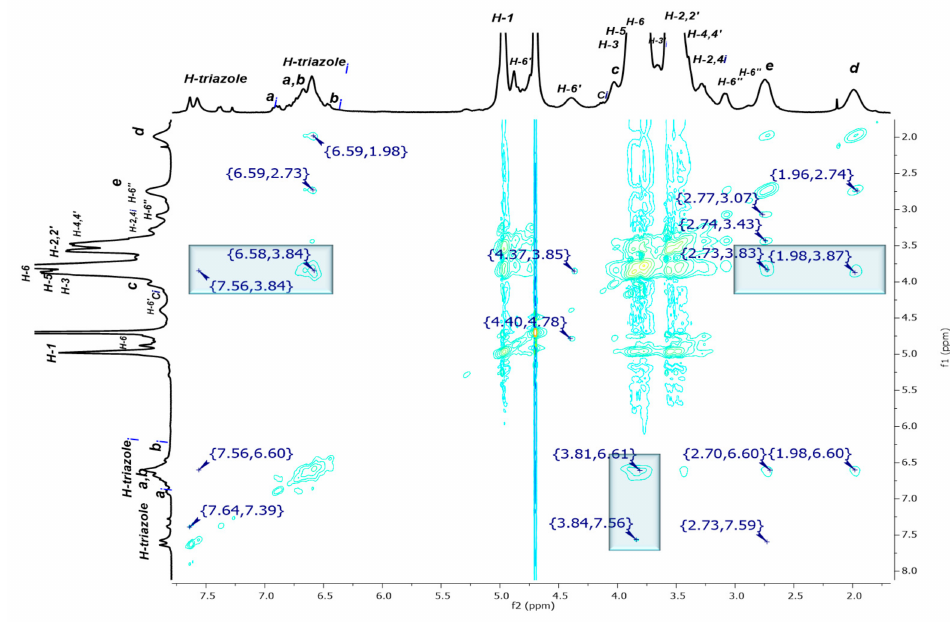
Figure 6. 2D NMR NOESY spectrum of P 3 N 3 -[O-C 6 H 4 -O-(CH 2 ) 3 - β CD] 6 ( I ) in D 2